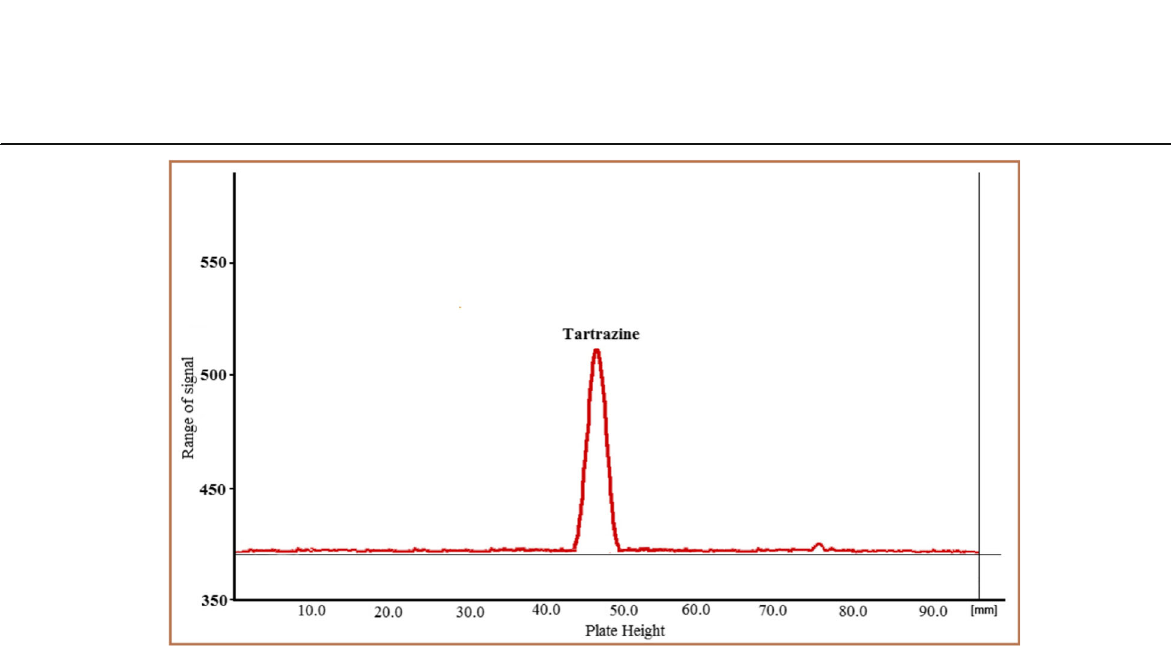
Fig. 10 Densitographic illustration of identification of tartrazine in Roscillin R syrup with preliminary separation from associated components on S 2 with M